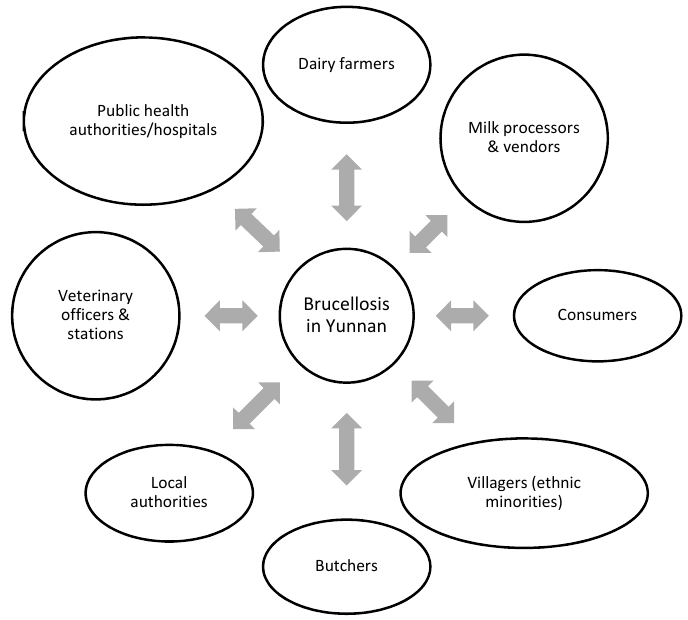
Figure 2. Stakeholders identified and included in the participatory study design.